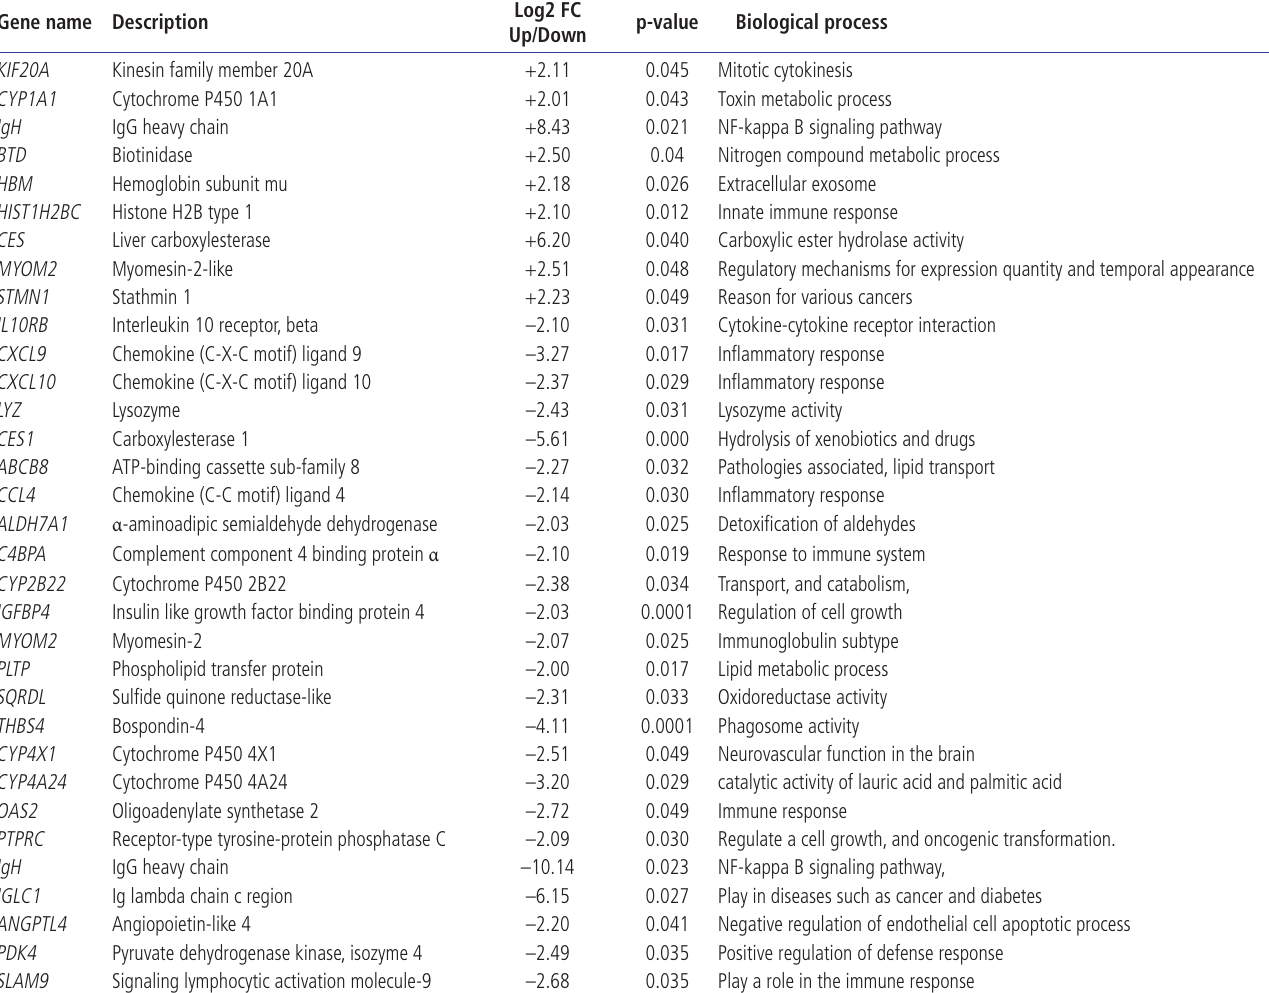
Table 2. Up- and downregulated genes in the kidney samples of DON (8 mg/kg) and ZEN (0.8 mg/kg) dietary treatment groups of